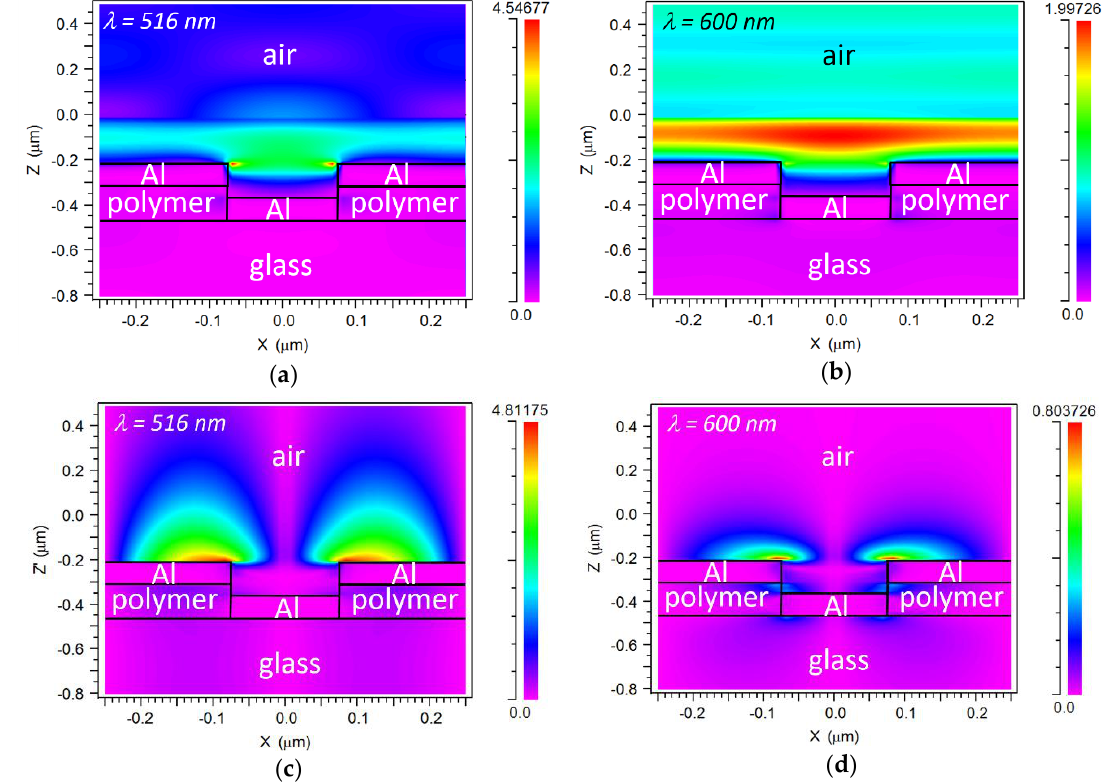
Figure 3. Cross-sectional electric field distributions of the studied configuration for d = 150 nm and h = 150 nm. ( a ) E x at resonance ( λ = 516 nm), ( b ) E x out-of-resonance ( λ = 600 nm), ( c ) E z at resonance ( = 516 nm), ( d ) E z out-of-resonance ( = 600 nm).